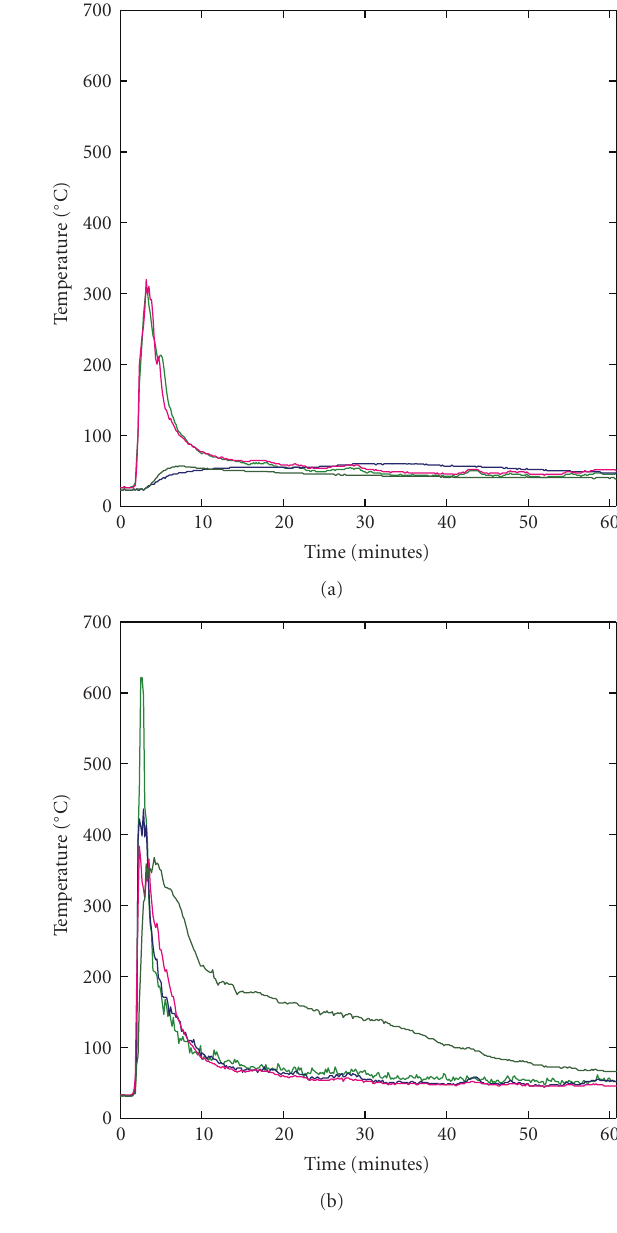
Figure 3: Soil temperatures at the soil surface during a prescribed sand pine scrub fire at Archbold Biological Station, Florida on May 25, 1993. Temperatures were recorded with copper-constantan thermocouples placed in vegetated (a) and open (b) microsites. Each microsite location was replicated four